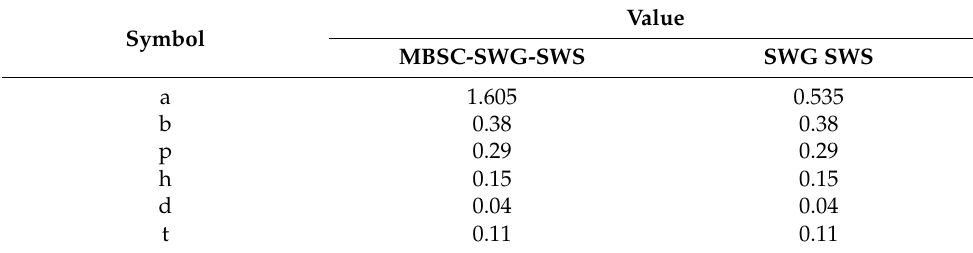
Figure 1. 3D model with sheet beams (red regions). ( a ) Left view of single beam SWG SWS. ( b ) Left view of MBSC-SWG-SWS. ( c ) The cut view of single beam SWG SWS. ( d ) The cut view of MBSC- SWG-SWS. Table 1. Optimized parameters of MBSC-SWG-SWS and SWG SWS.